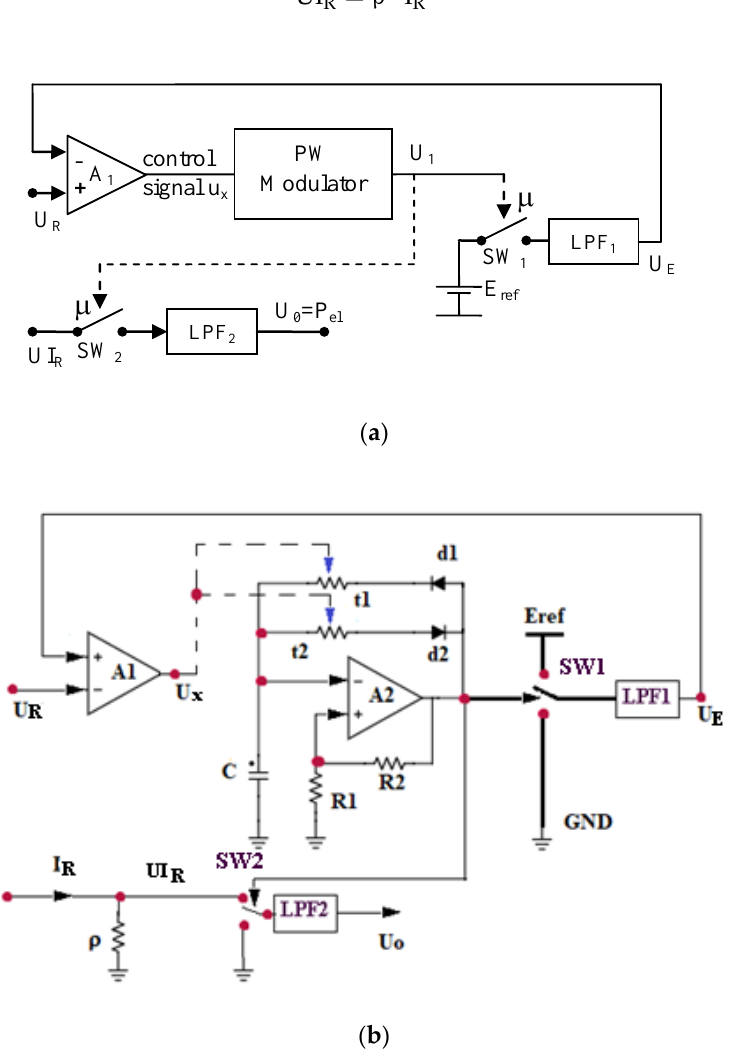
Figure 8. Proposed electrical power transducer: ( a ) Principle of operation; ( b ) electric circuit.